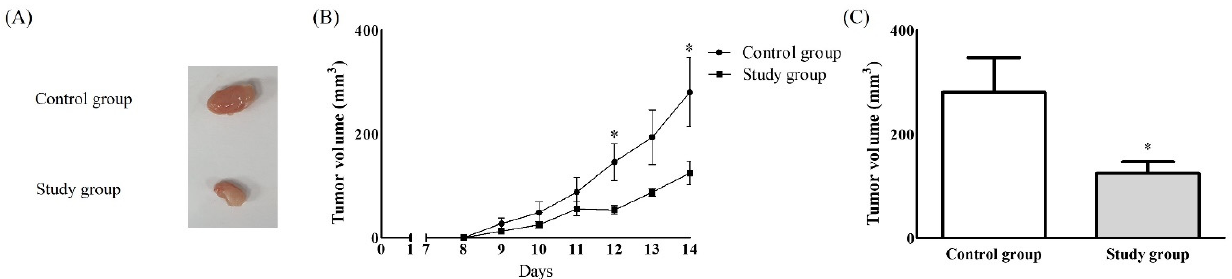
Figure 3. Tumour growth after subcutaneous injection of CT26 cells. ( A ) Tumour, ( B ) Tumour volume according to the time, ( C ) Tumour volume on 14 days after the injection. *: p < 0.05.